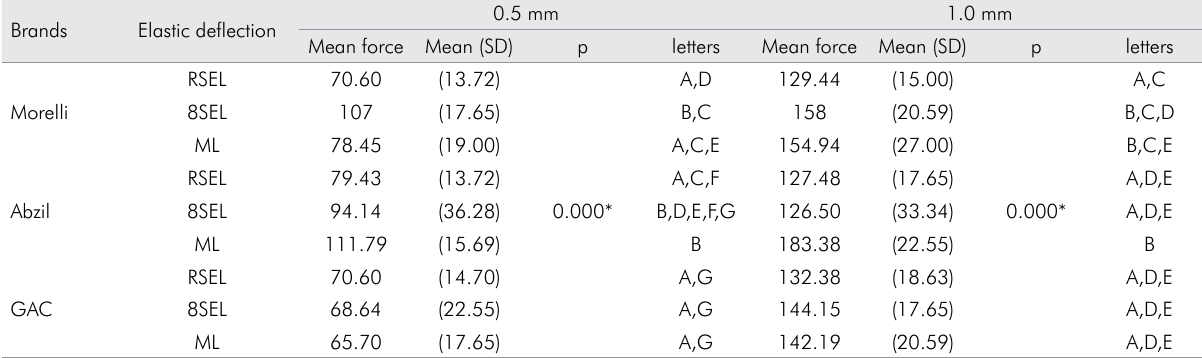
*Statistically significant at p < 0.05; Different letters represent statistically significant differences.